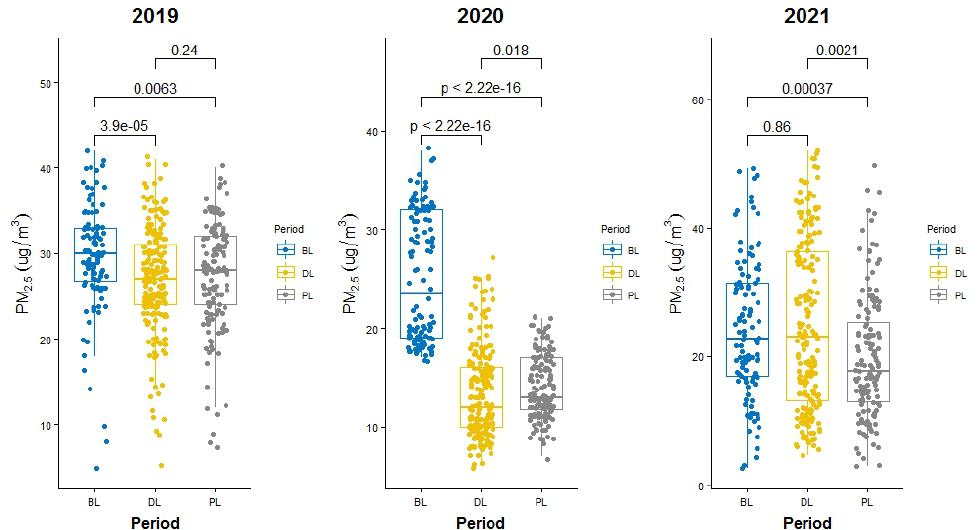
Figure 3. Comparison of PM 2.5 concentration by period (BL, DL, and PL) and year, using the Wilcox